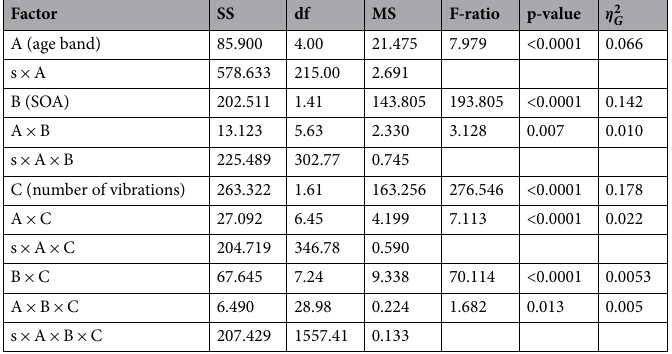
Table 1. ANOVA table of mean reported numbers in the experiment.